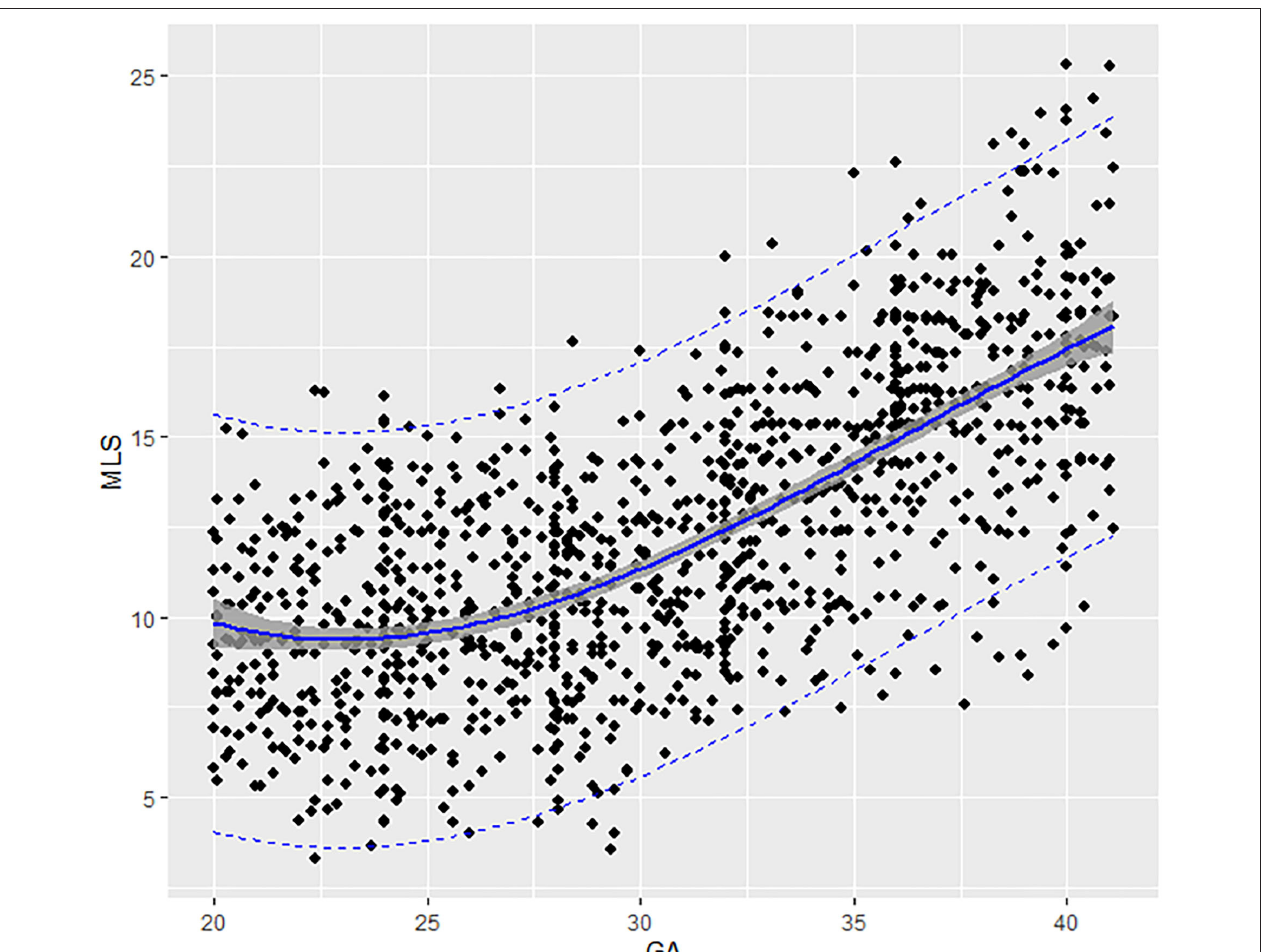
FIGURE 4 | Scatter plots of the MLS based on GA: There was a third-degree fractional polynomial smoothing regression model between GCS and GA. Fitted percentiles according to gestational age are presented as solid lines. The 95% CI of the fitted mean value is presented as a gray area. The 5th and 95th percentile limits are presented as dashed lines. GA, gestational age; MLS, mean longitudinal strain.